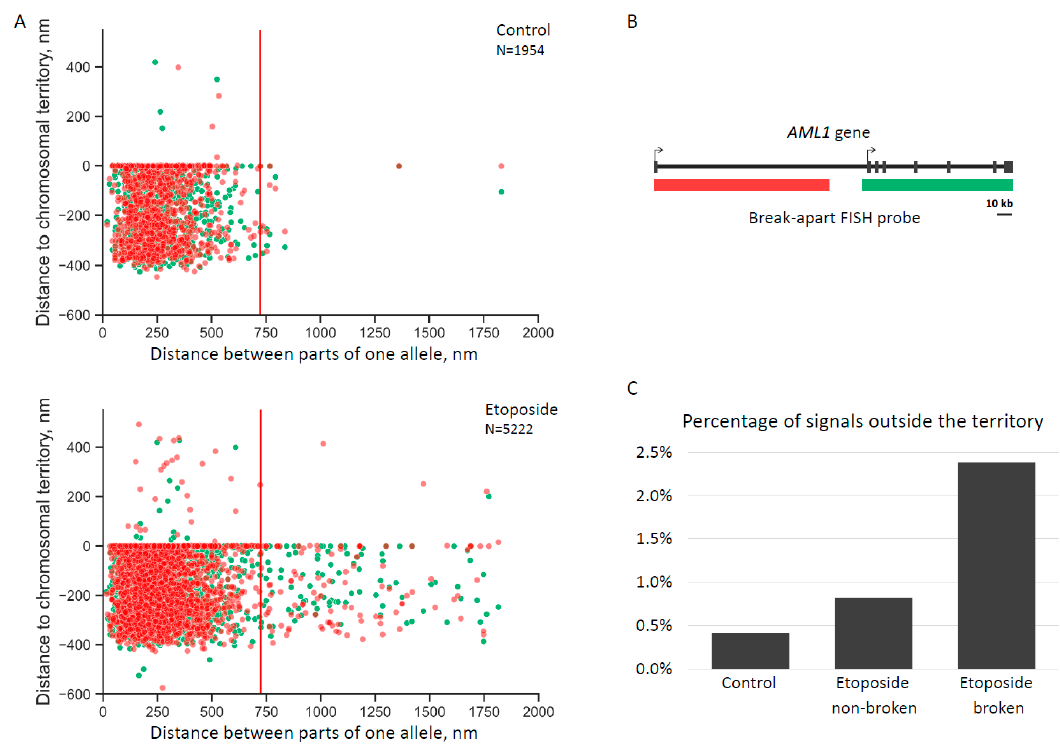
Figure 3. ( A ) Scatterplots reflect the distances between regions of one allele (X-axis) and the distance to the territory (Y-axis, the value 0 reflects the border of the chromosome territory) for each AML1 region. Red and green colors reflect upstream and downstream regions of the AML1 break-apart FISH probe. ( B ) The upper scatter plot shows the data for the control cells, and the lower scatterplot depicts the etoposide-treated cells. N is the total number of dots in the scatterplot. ( C ) Percentage of alleles localized outside the chromosomal territory in control cells, as well as non-broken alleles and broken alleles in etoposide-treated cells (see statistic in Table S2).